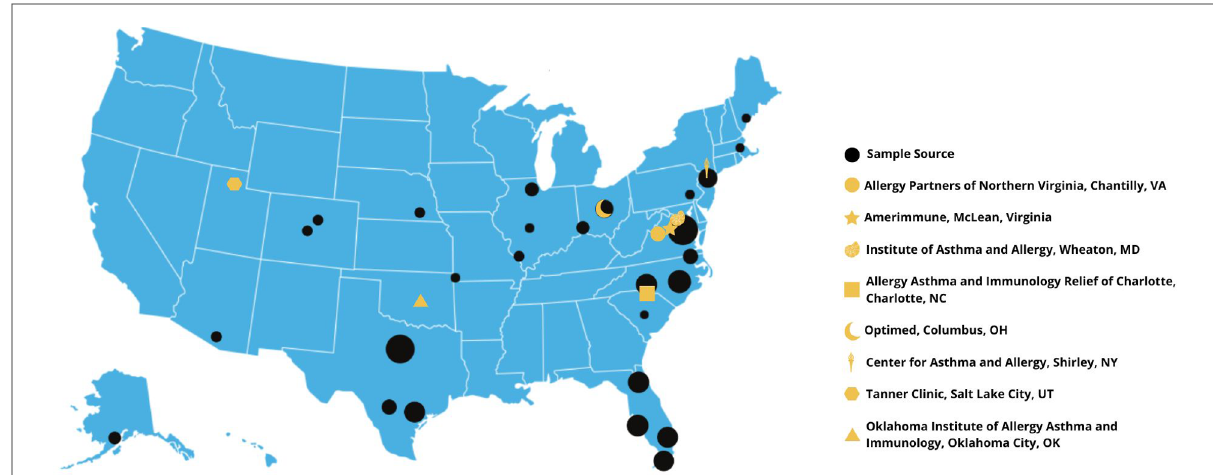
FIGURE 3 Sample sources and laboratory location for BAT in the United States. Dark circles represent sources for the blood samples. Size of each circle represent sample size from each location. Total samples are over 1,000 between year 2018 and 2021. The yellow symbols represent CLIA/CAP accredited laboratory locations capable of performing BAT as an